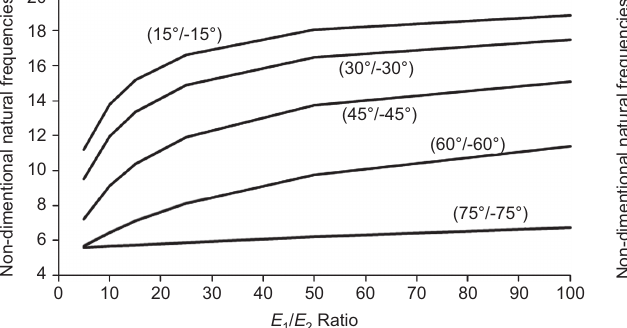
Figure 10 Non-dimensional natural frequencies of cantilever angle- ply composite beam depending on E